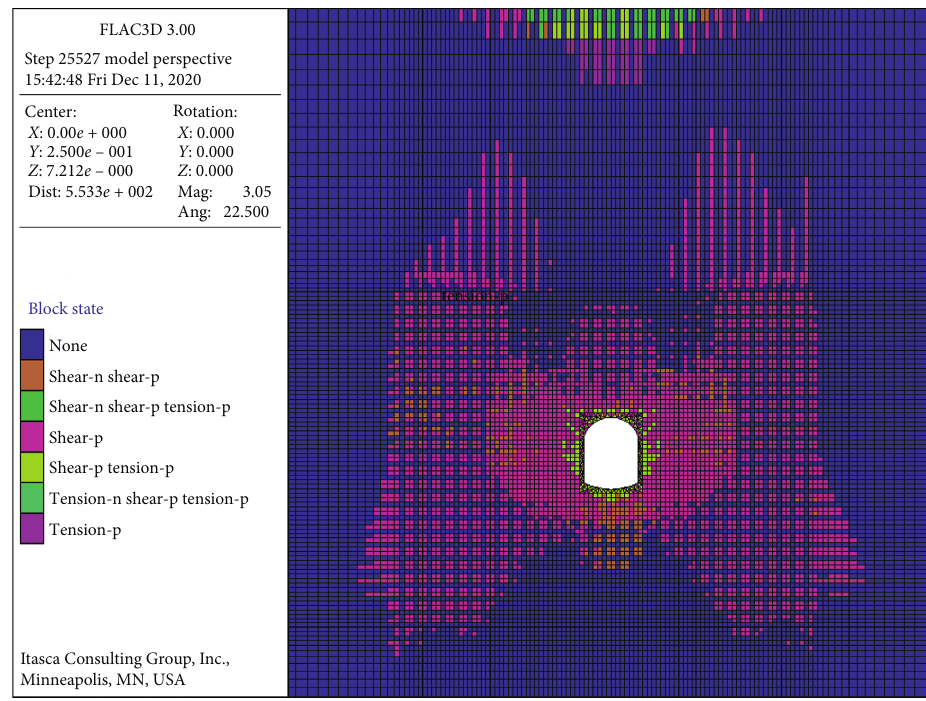
Figure 4: Distribution of plastic zone of surrounding